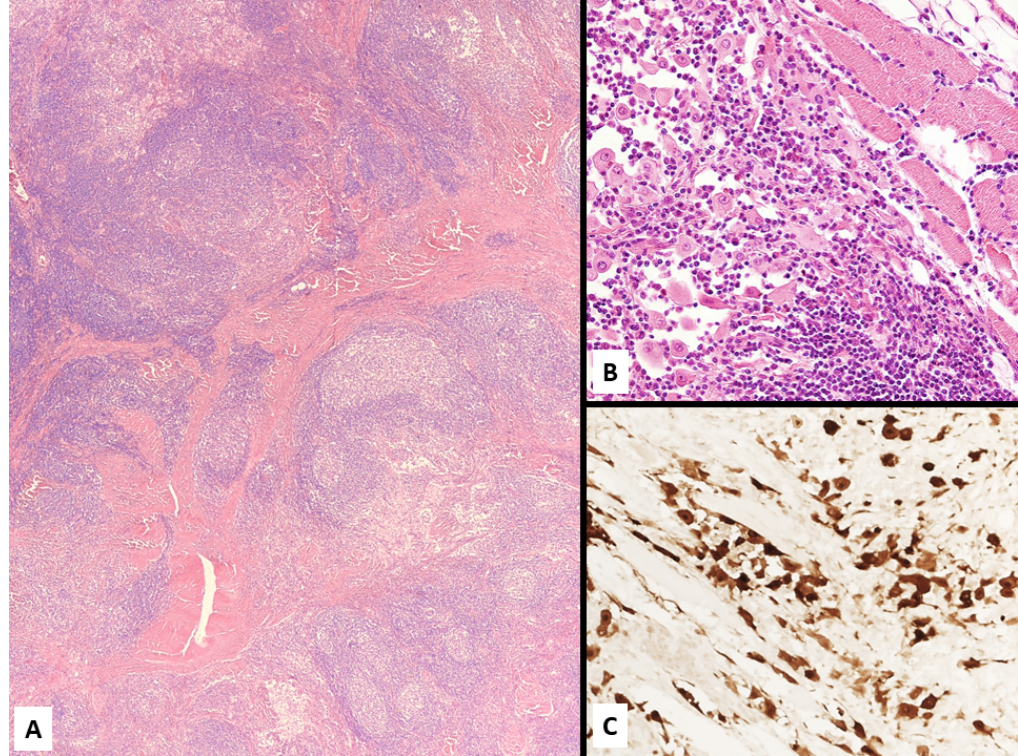
Figure 9. Lymphohistiocytoid mesothelioma consisting of a heterogeneous growth of mixed inflammatory cells ( A , mainly lymphocytes and plasma cells) dissected by fibrotic tissue and discohesive malignant epithelioid mesothelial cells ( B ) expressing calretinin ( C ).